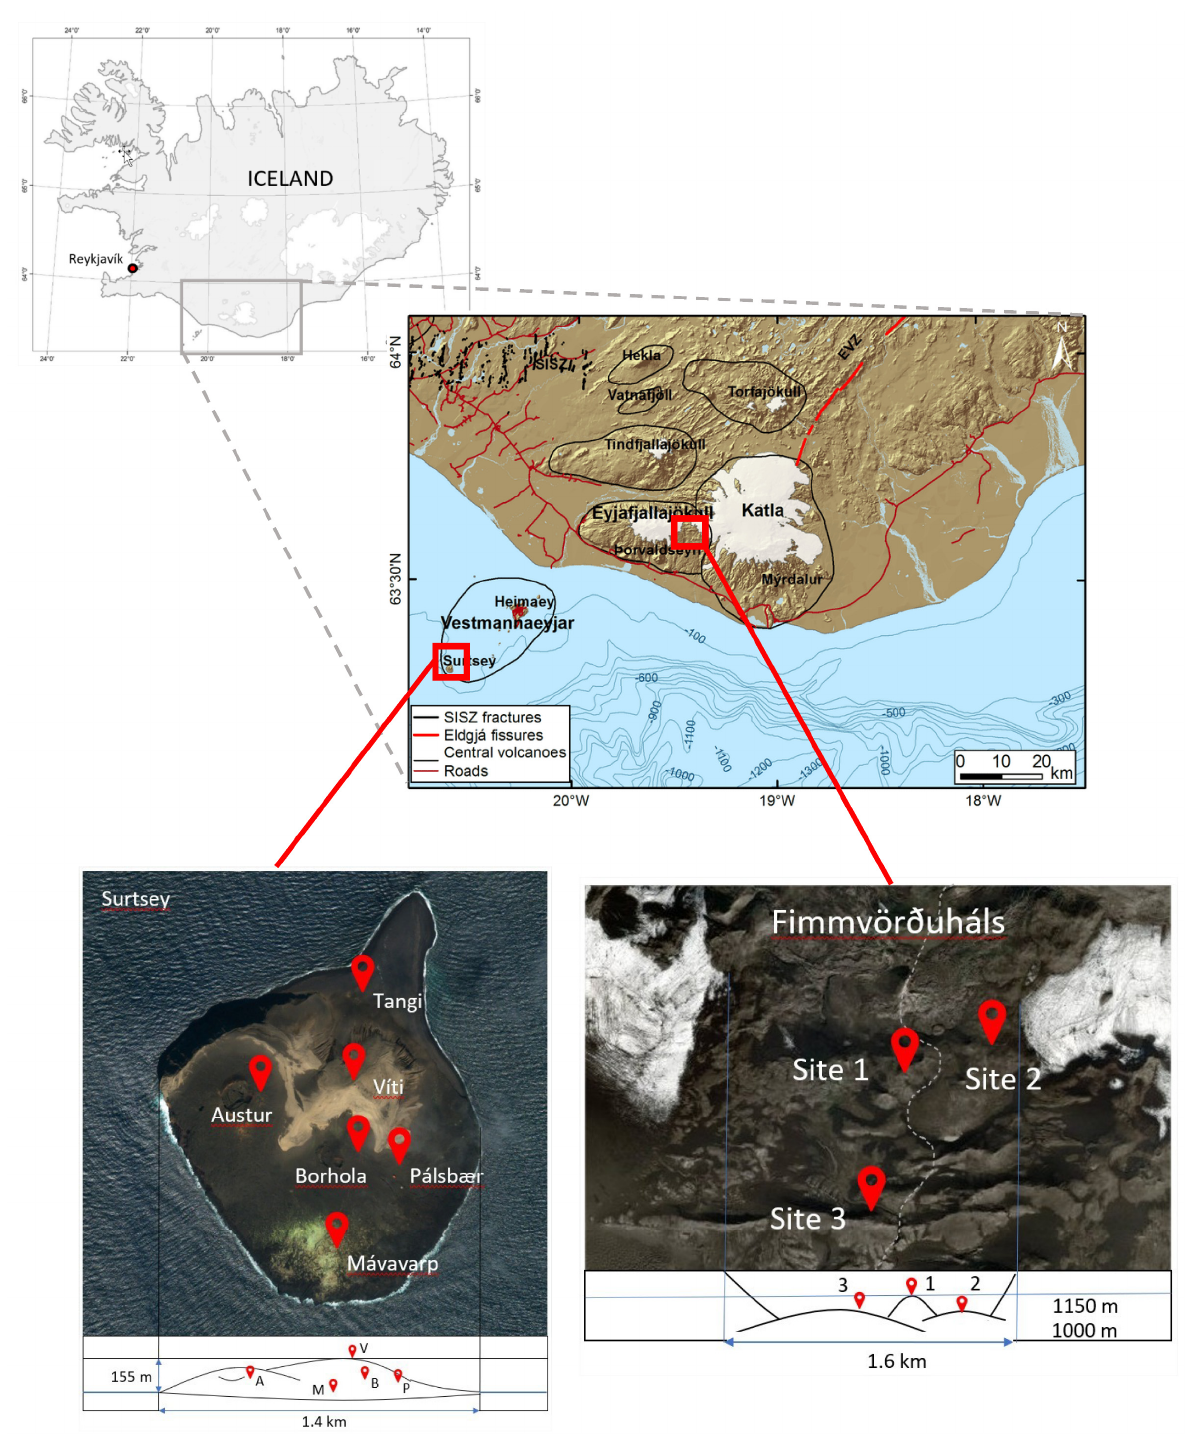
Figure 1. Locations of the Surtsey and Fimmvörðuháls sampling sites and the stations.